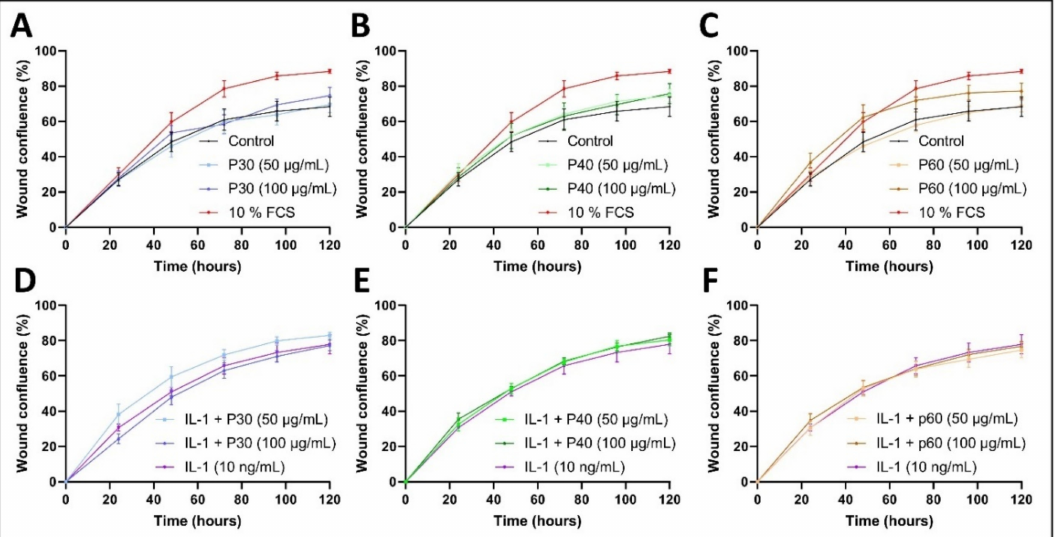
Figure 11. Wound filling analysis following a scratch wound assay. Human articular chondrocytes (HACs) were seeded at P2. At 90% confluency, a scratch wound assay was performed using a WoundMaker TM kit (Essen BioScience) and then the treatments were added. HACs were incubated in the presence of a culture medium containing 2% FCS (Control), and P30, P40, or P60 at 50 and 100 µ g/mL without ( A – C ) or with IL-1 ( D – F ). The wound confluences were calculated using ImageJ software. P30, P40 and P60: Promerim ® 30, Promerim ® 40 and Promerim ® 60 ( n =